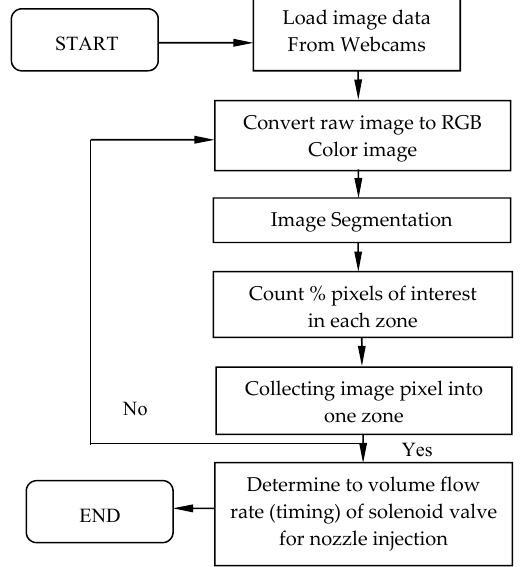
Figure 2. Image processing algorithm.